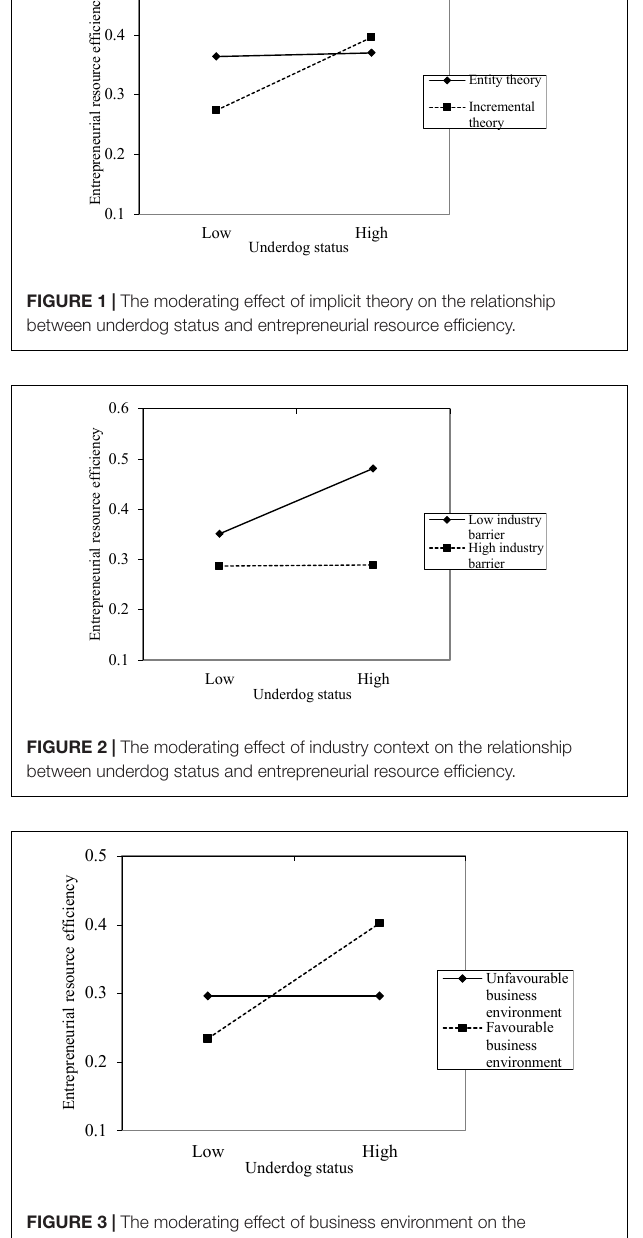
correlated ( β = 0.060, p < 0.01). Hypothesis H1 is verified